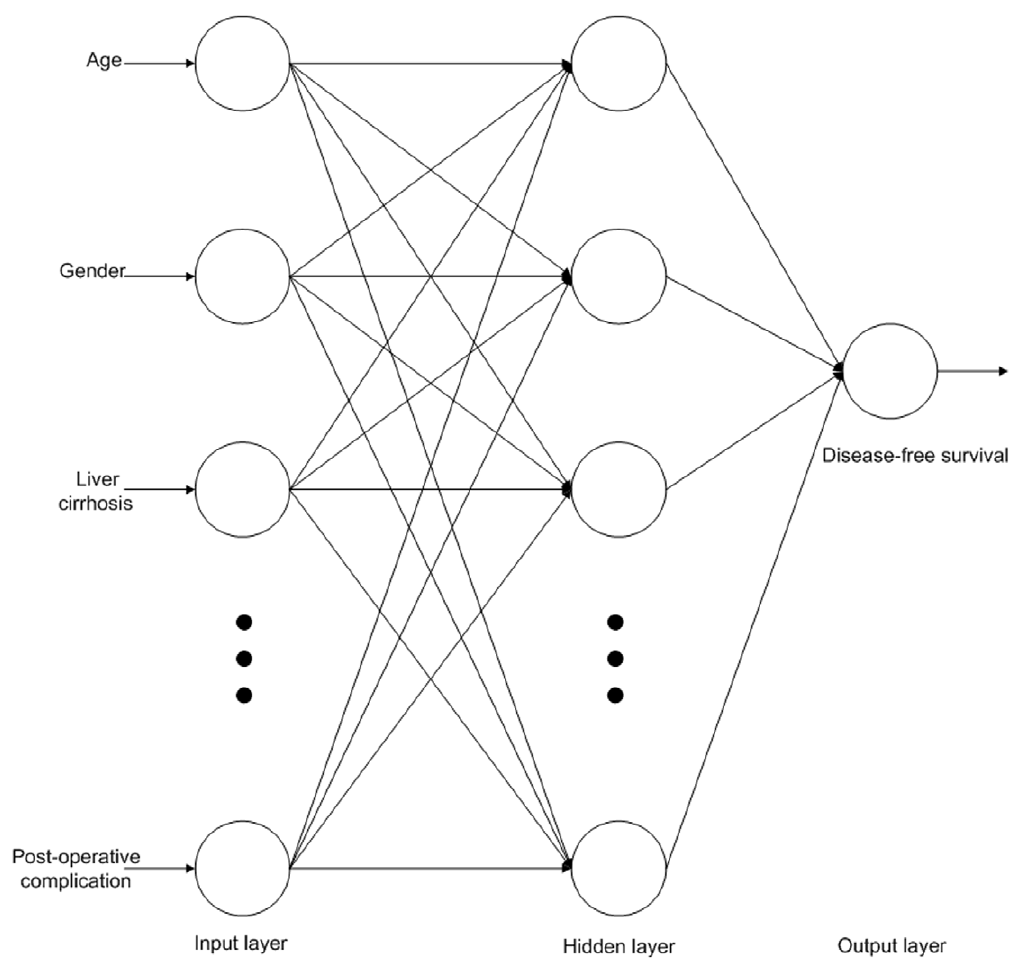
Figure 1. Framework of artificial neural network for the 1-, 3- and 5-year disease-free survival models. The input layer in each of the three models contained 17 neurons. In the hidden layers, the numbers of neurons were 30, 17 and 7 the 1-, 3- and 5-year models, respectively. The output layer in each of the three models had only one neuron representing the disease-free survival of HCC patients after hepatic resection.